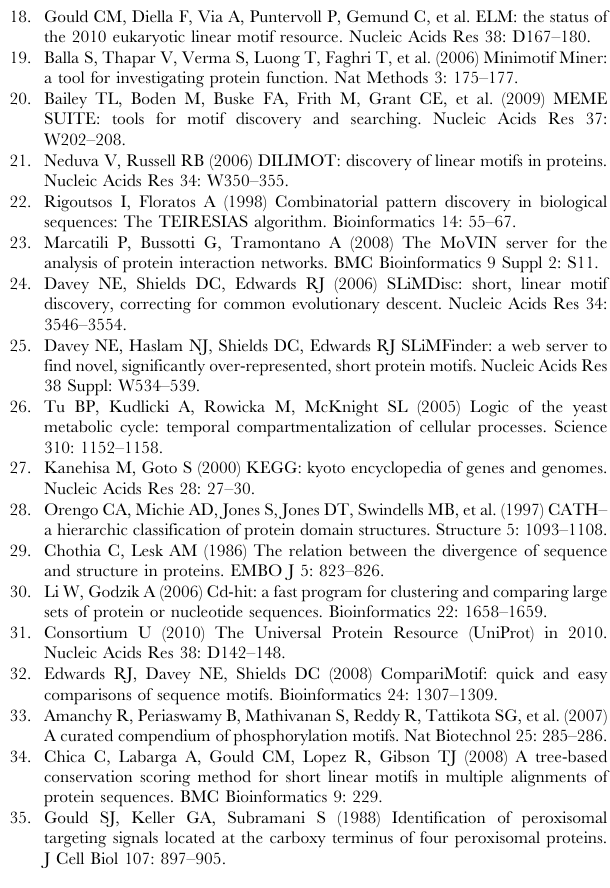
assigned to a loop (disordered) region if at least 50% of the residues belonging to the motif true positive matches are in loop (disordered) regions, respectively. Table S1 Total number of proteins belonging to the pathways under study and number of motifs per pathway. Table S1.1: Data obtained from the analysis of the 25% non-redundant sequence dataset. Table S1.2: Data obtained from the analysis of the 40% non-redundant sequence dataset. Table S2 List of novel motifs. Table S2.1: List of novel motifs obtained by restricting the analysis to the 25% non-redundant sequence dataset. Table S2.2 – List of novel motifs obtained by restricting the analysis to the 40% non-redundant sequence dataset. Table S3 List of known motifs. Table S3.1: List of known motifs obtained by restricting the analysis to the 25% non-redundant sequence dataset. Table S3.2: List of known motifs obtained by restricting the analysis to the 40% non-redundant sequence dataset. Table S4 List of motifs shared by two or more of the species under study. Table S4.1: List of motifs shared by two or more of the species under study in the 25% sequence non- redundant dataset. Table S4.2: List of motifs shared by two or more of the species under study in the 40% non-redundant sequence dataset.